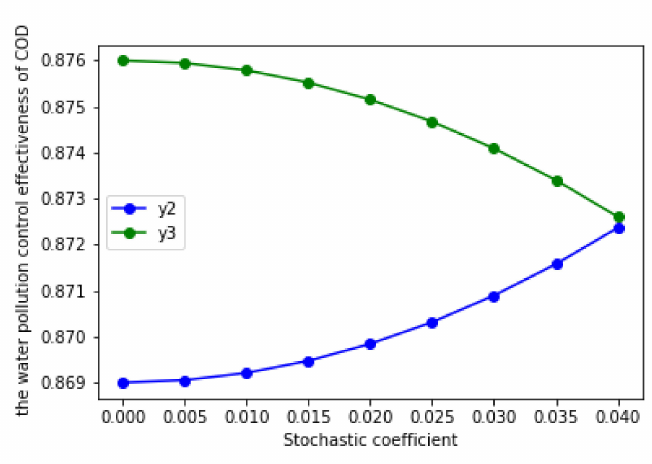
Figure 5. The interval of random interference coe ffi cient ( σ ) to ensure the validity of the